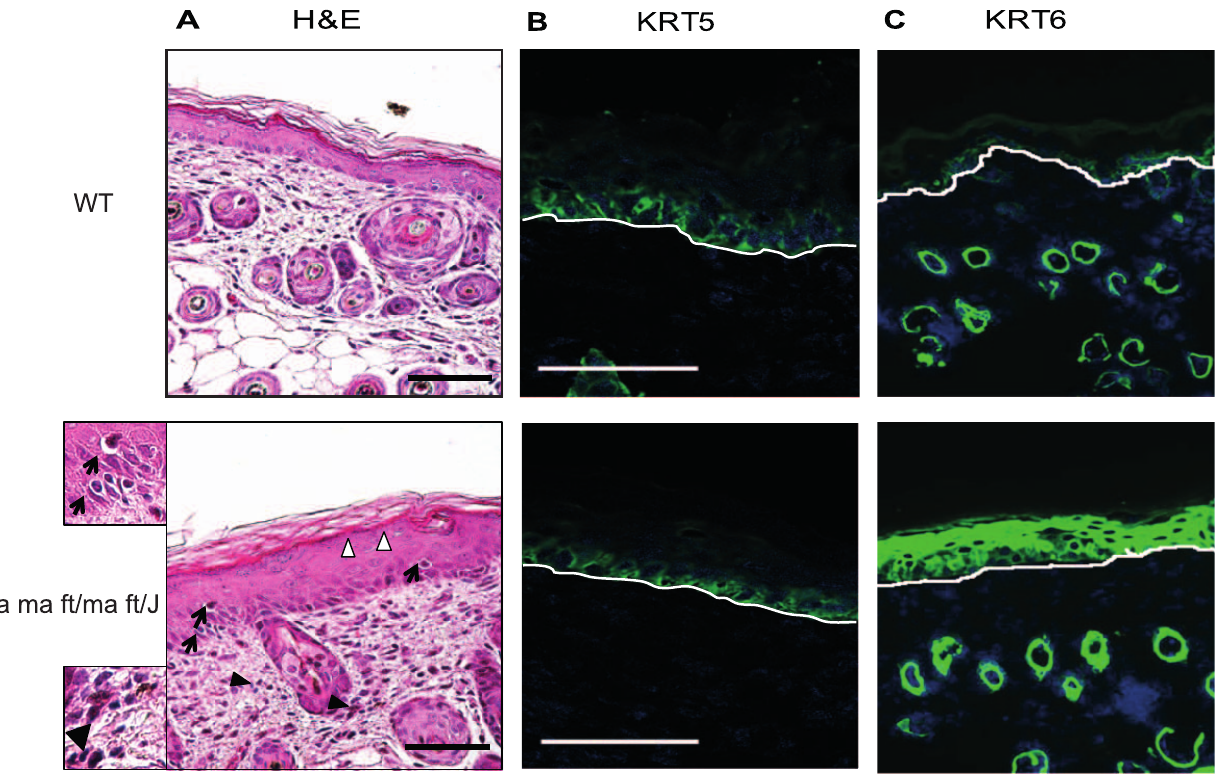
Figure 1. Acanthosis and inflammation in 5-days-old a/amaft/maft/J skin. A. Dorsal skin of P5 C57blk6/J wild type (WT) and flaky tail ( a/a ma ft/ma ft/J ) mice was collected, fixed in PFA 4% and embedded in paraffin. H&E staining was performed and sections were visualized with a 20x lens. Thickening of the epidermis, hypogranulosis (white arrowheads), lymphocytic exocytosis (arrows) and inflammatory infiltrates (black arrowheads) are observed. Magnification of two representative fields is presented in order to distinguish inflammatory infiltrates in the a/a ma ft/ma ft/J mouse skin. ( B and C ) . Dorsal skin biopsies were embedded in OCT and cryosections were prepared. Immunofluorescence was performed using antibodies against keratin 5 (KRT5) (B) and keratin 6 (KRT6) (C) . Fluorescence was visualized with a 20x lens (LSM 700 Zeiss confocal microscope (B) or Zeiss Axiovision microscope (C)). Scale bars=50 m m.